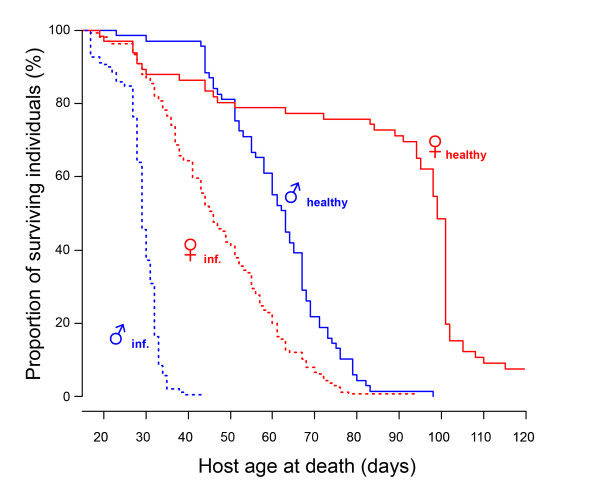
Survival of control (solid lines) versus infected (dotted lines) of male and female hosts. Control D. magna live about twice longer than infected ones. P. ramosa reduces the lifespan of both female and male Daphnia. We did not find a statistically significant difference between sexes of such lifespan reduction. The median lifespan was reduced in both sexes by exactly 50%.